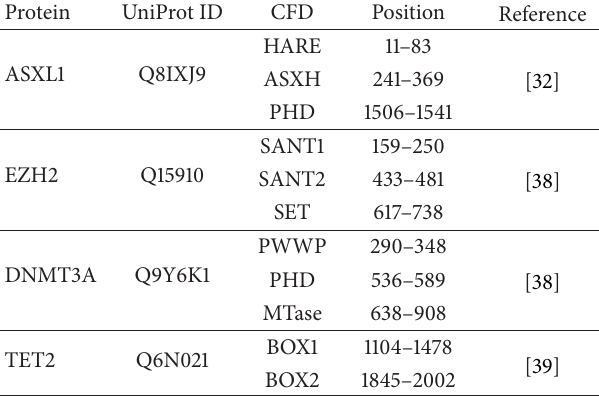
Table 1: Sequences, their UniProt IDs, CFDs, and the relevant